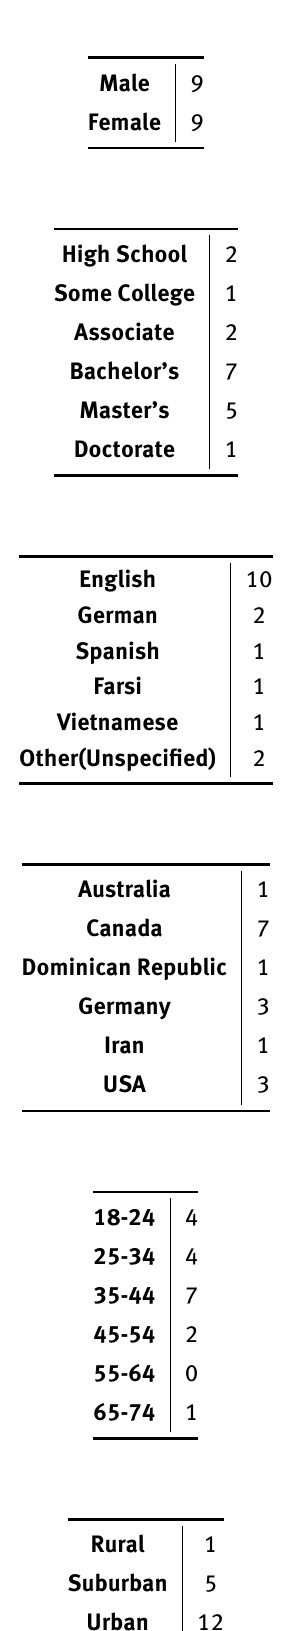
Table 7: Childhood home